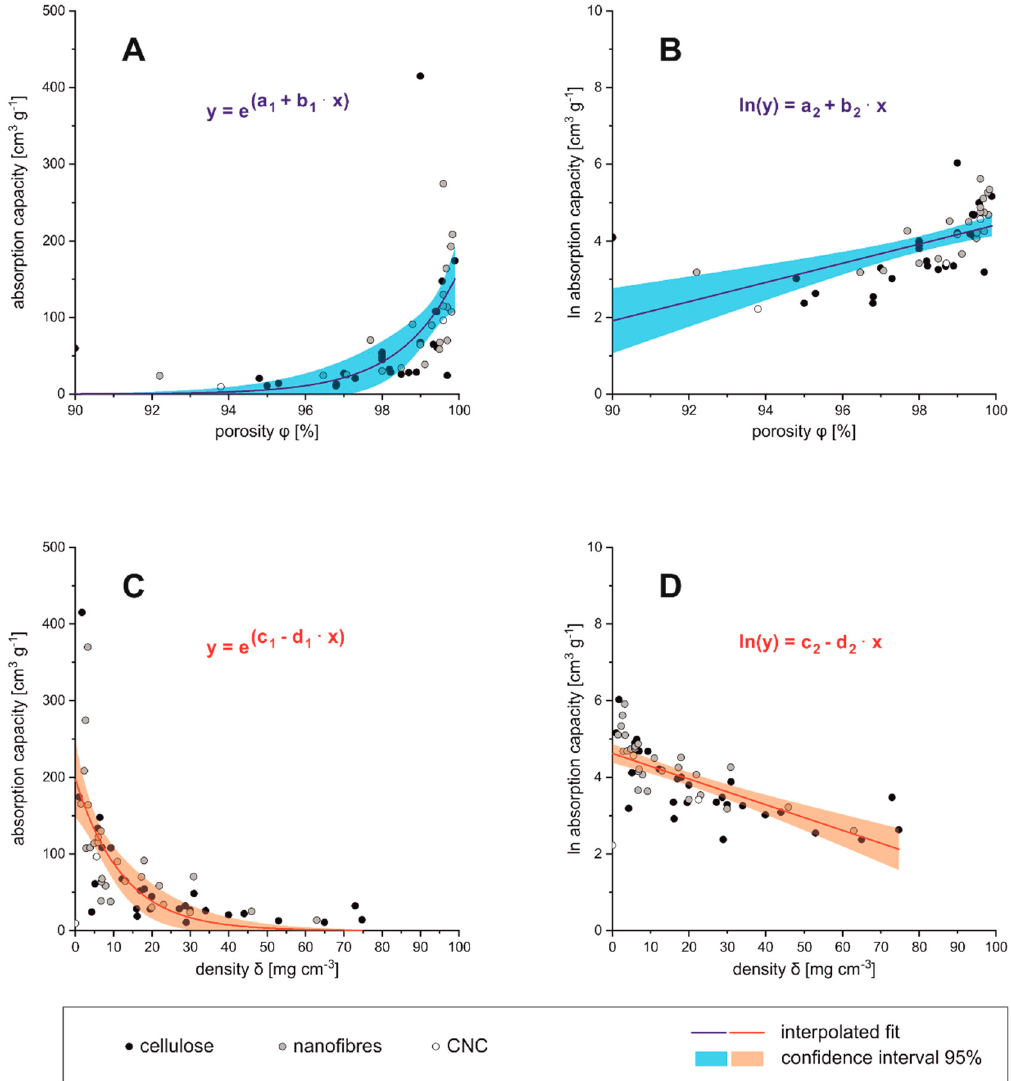
Figure 5. Density ( A , B ) and porosity ( C , D ) in relation to absorbance capacity. Correlation between Adsorption Capacity and Surface-Related